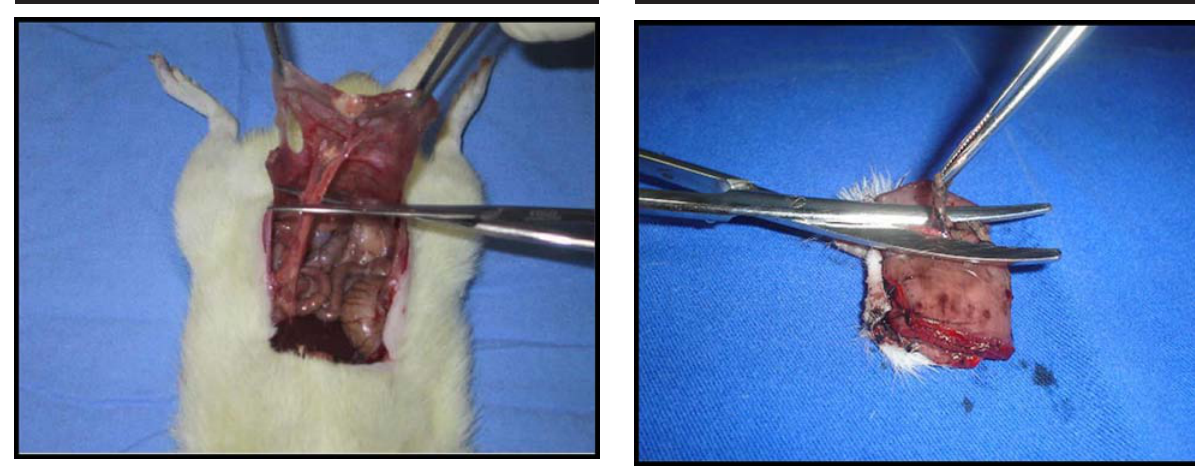
FIGURE 5 - Adhesions exeresis after Indian blue stain